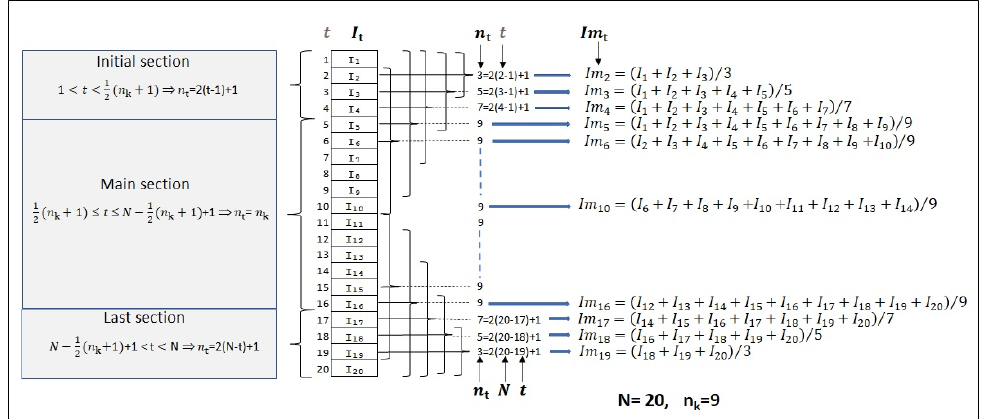
Figure A1. An example of a numerical pattern used to deduce the extended centered moving average method to calculate the Im t mean series. The n t values of the initial and last sections are sequences of odd numbers, less than n k . The n t value of the main section is n k . There are no defined values for t = 1 and t = N.